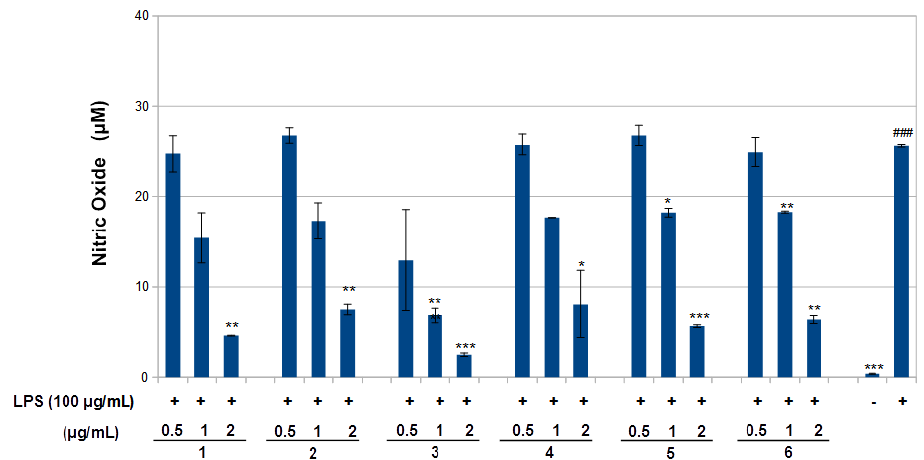
Figure 5. Inhibition of nitric oxide (NO) production by compounds 1 – 6 in LPS-stimulated RAW 264.7 macrophages. RAW 264.7 cells were stimulated by LPS (100 ng/mL) for 6 h and then treated with the indicated concentrations of compounds 1–6 for 24 h. NO was measured using Griess reagent. Values are presented as mean ± standard deviation of three independent experiments. ### p < 0.001 control group as compared to LPS-treated group. * p < 0.05, ** p < 0.01, and *** p < 0.001 were compared with the LPS-alone group. -: cells without treatment, +: cells previously treated with LPS.